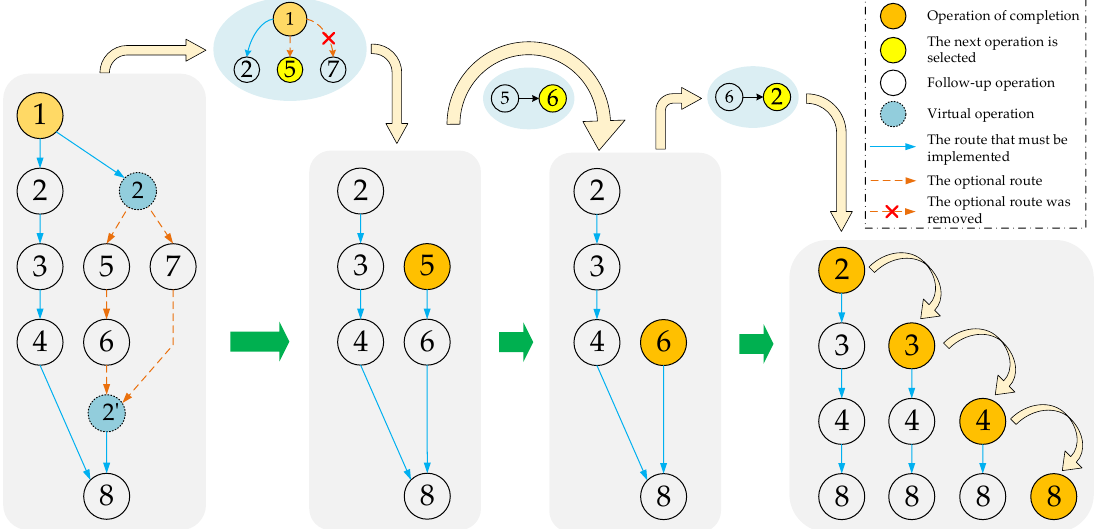
Figure 2. Dynamic updating diagram of process planning based on process tree.